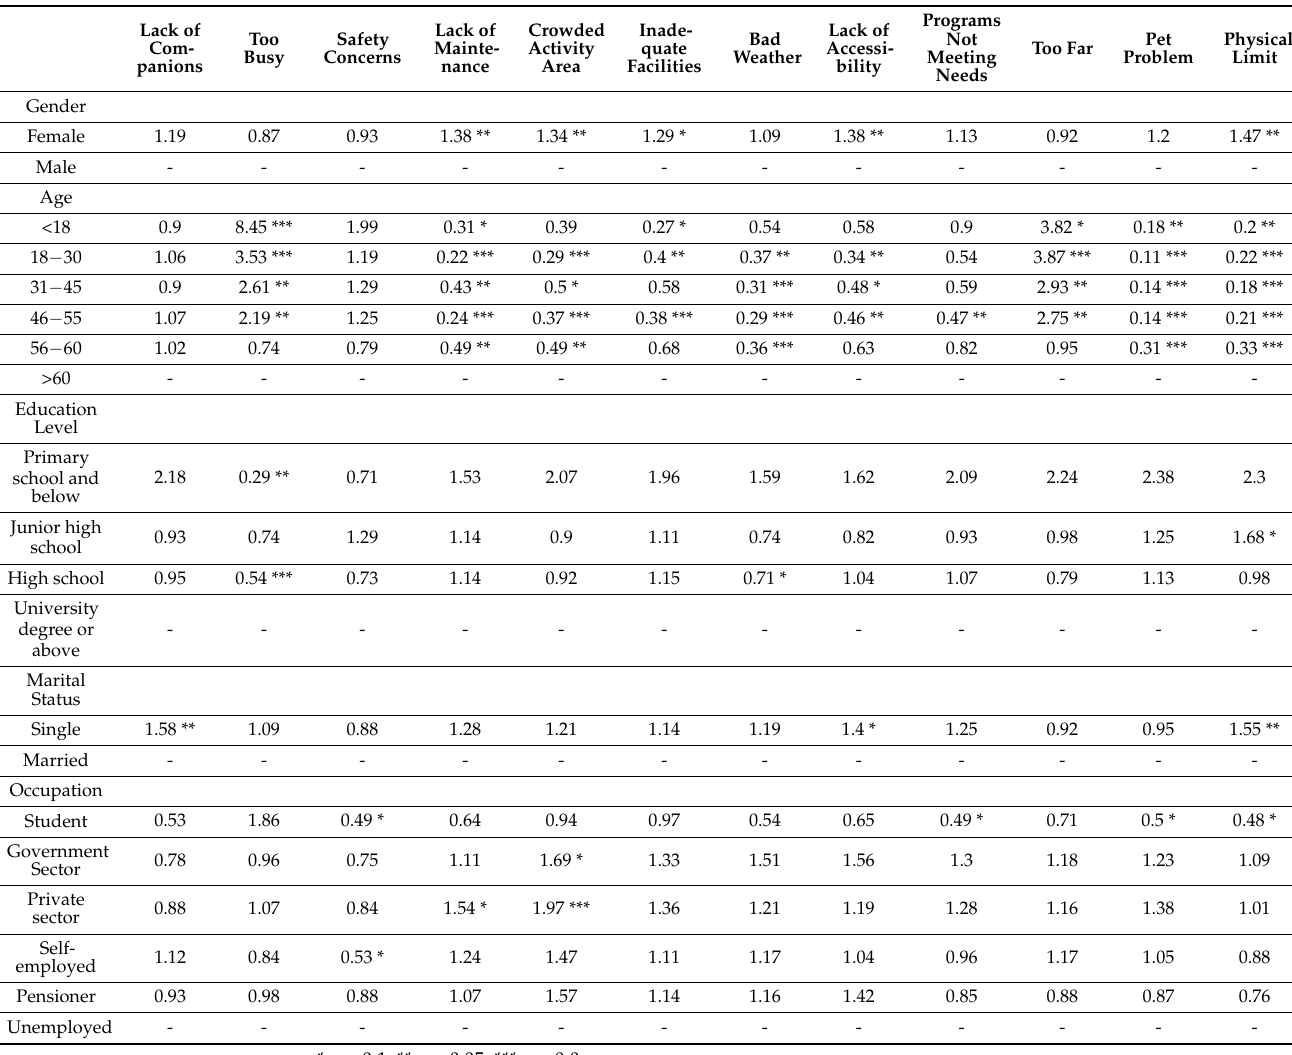
Table 4. The respondents’ constraints in using the green space in an old residential neighborhood (ordered logistic regression model measure the odd ratio (OR) and p